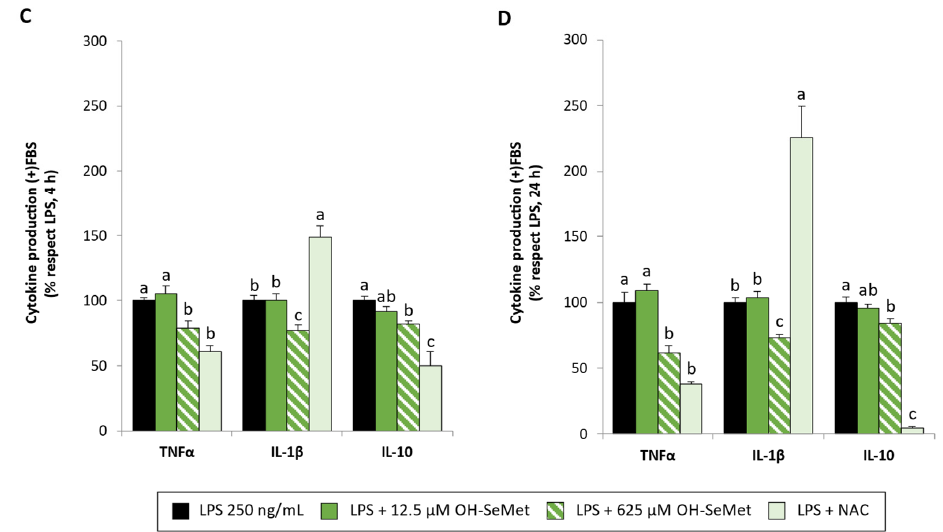
Figure 8. Cytokine production (TNF α , IL-1 β , and IL-10) in macrophages maintained in ( − )FBS or (+)FBS for 24 h ( A – D , respectively), supplemented for 24 h with 12.5 and 625 μ M OH-SeMet or 10 mM NAC and then stimulated with LPS (100 and 250 ng/mL) for 4 or 24 h ( A – D , respectively). The results are expressed as mean ± SEM of n = 9 cultures. Different letters denote significant differences ( p < 0.05) between conditions for each cytokine.